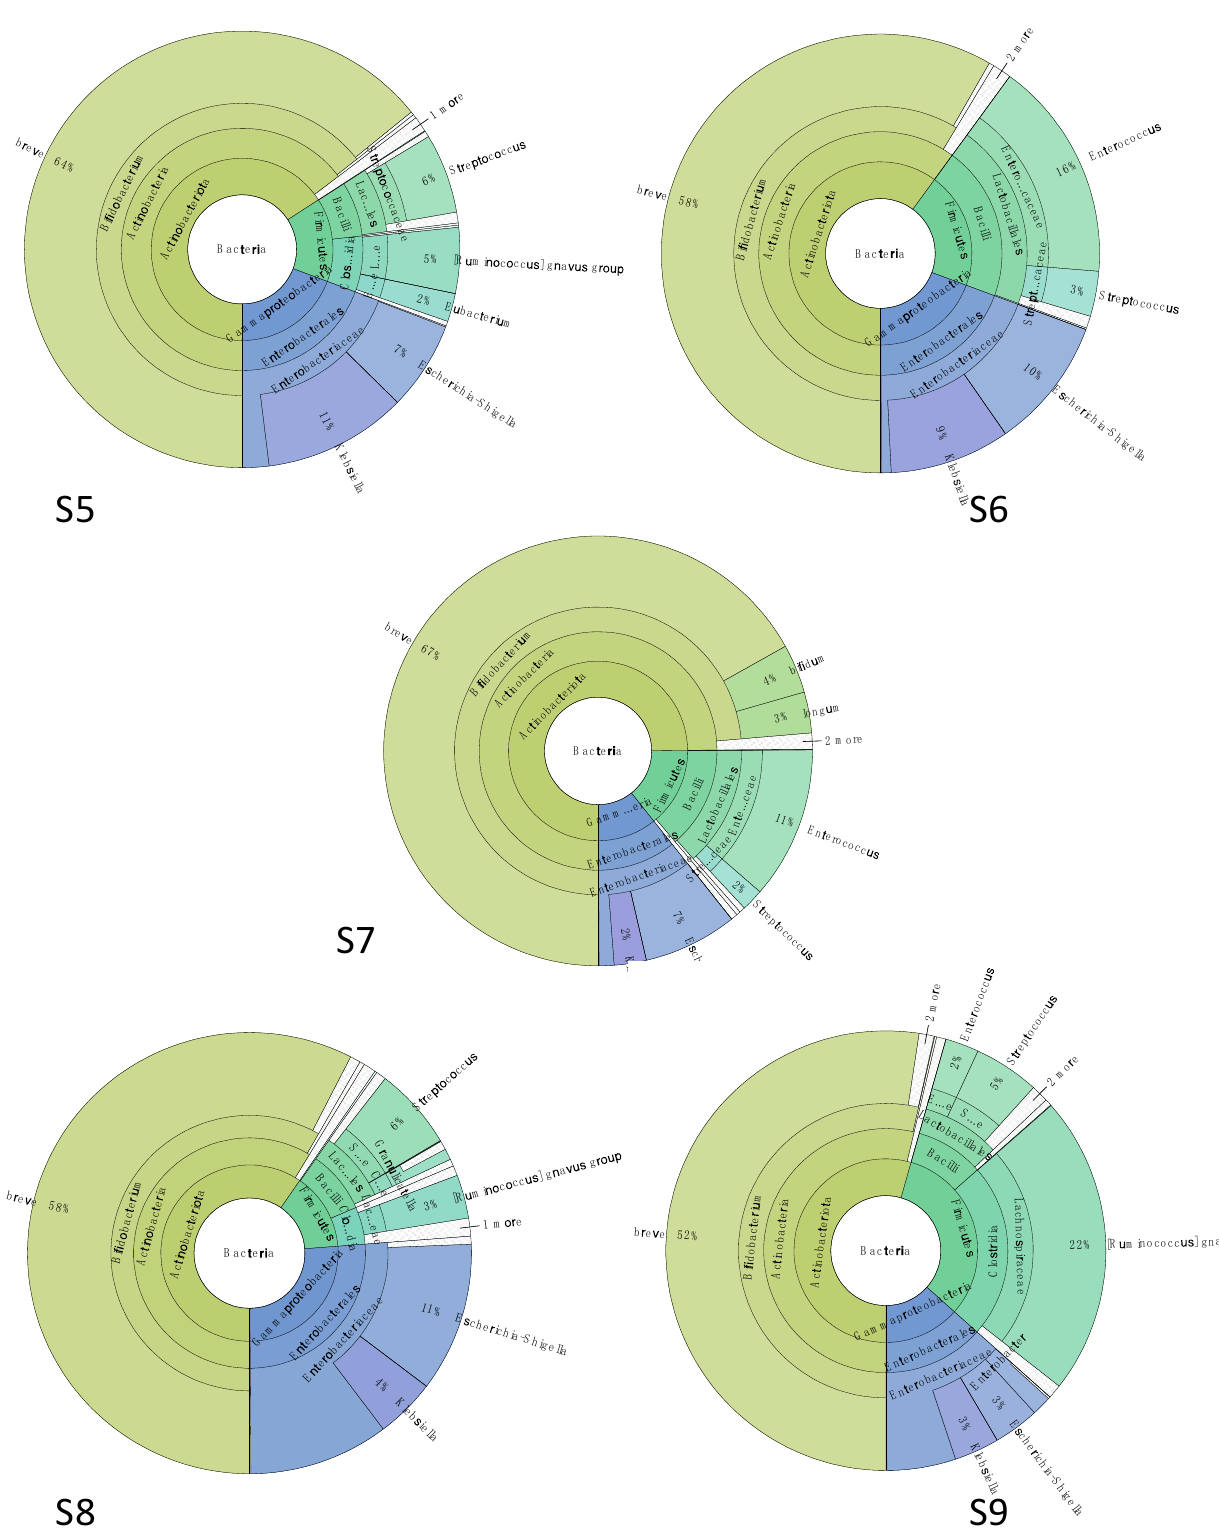
Figure 5. Microbiota structure assessed by metabarcoding data at 4 months of life. Samples ( S5 ) was collected before the fifth antibiotic therapy, sample ( S6 ) was collected 1 day after the end of fifth antibiotic therapy, and on the first day of probiotic supplementation, ( S7 ) was collected 7 days after the end of 5th antibiotic therapy and on the sixth day of probiotic supplementation, ( S8 ) was collected 14 days after the end of fifth antibiotic therapy and 13 days of probiotic supplementation, and ( S9 ) was collected 21 days after the end of fifth antibiotic therapy and at the end of probiotic supplementation.